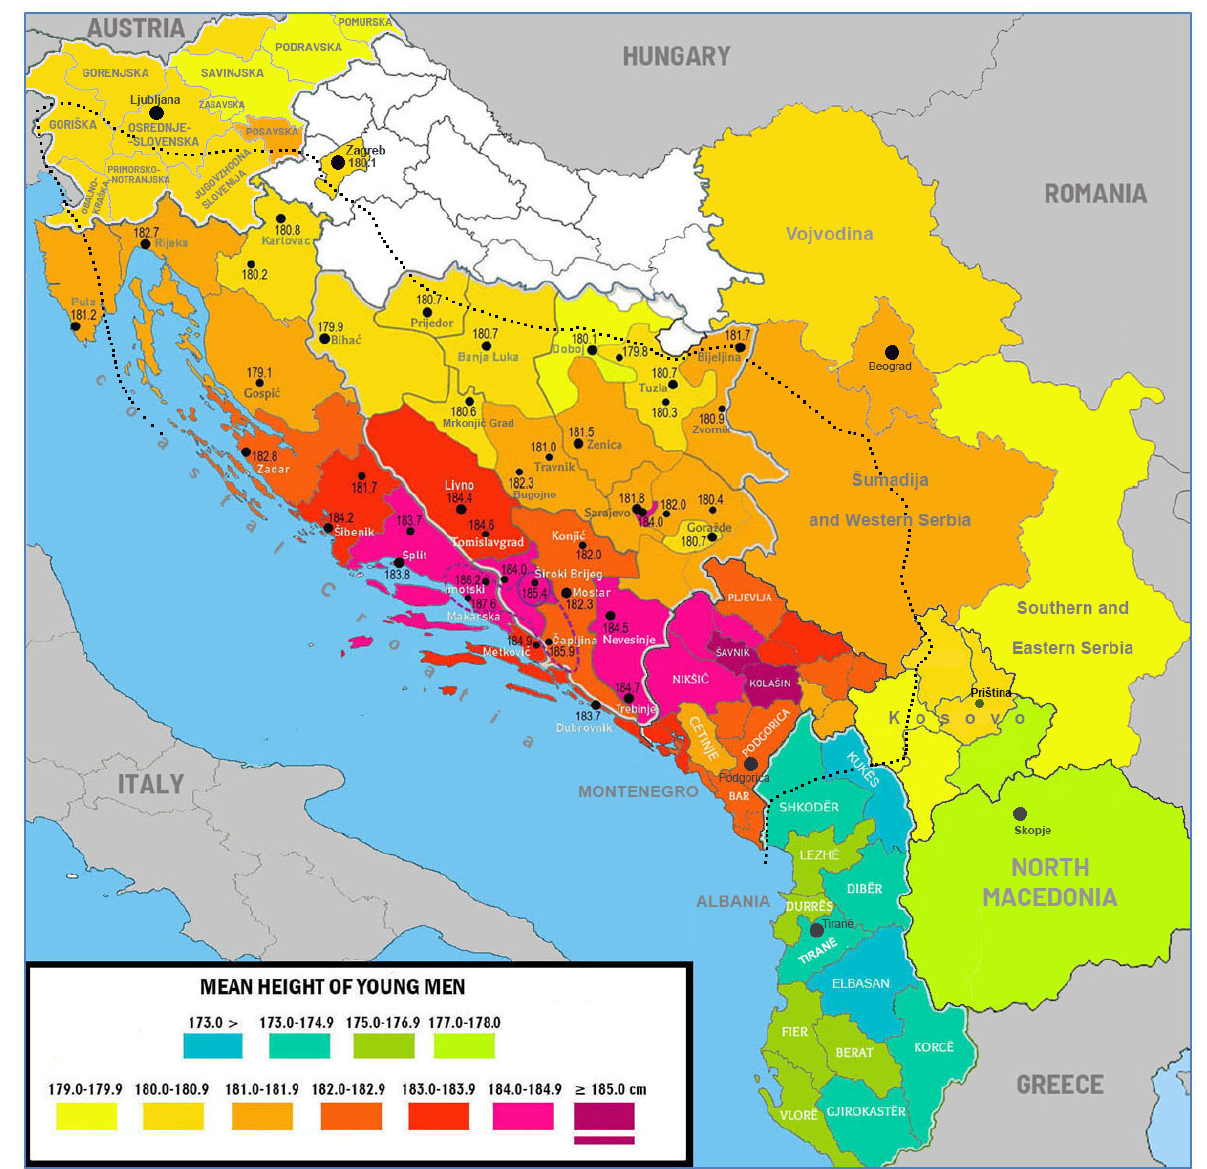
Figure 2. Regional differences in male height in the former Yugoslavia and Albania, including the means of individual towns in Croatia and Bosnia and Herzegovina. The data are based on studies listed in Table 1. For Zagreb, see Petranovi ć et al. [15]. The interrupted violet line demarcates an area with urban means above 185 cm. The approximate border of the Dinaric Alps is shown by a dotted line.